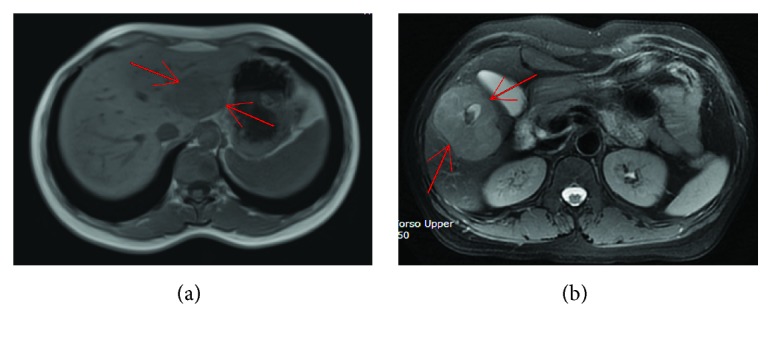
Image examination of primary hepatic neuroendocrine carcinomas. (a) MRI revealed the size of about 5.5 × 4.0 cm, slightly longer T1 and T2 signal masses, a clear boundary, and an uneven internal signal in the left lateral lobe of the liver. (b) Contrast-enhanced MRI revealed an irregular mixed appearance in the right lobe of the liver.